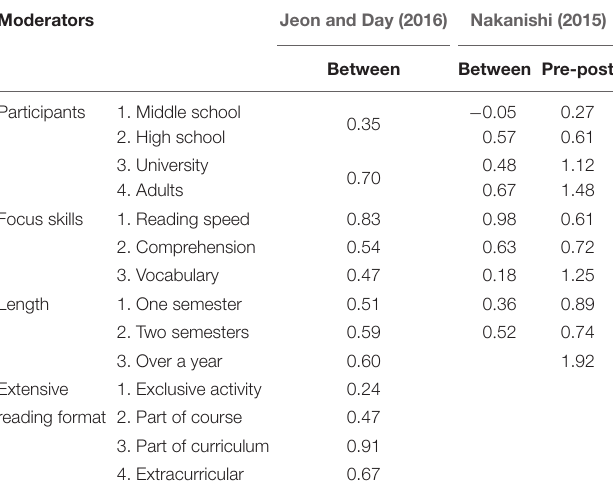
TABLE 2 | Different effects of extensive reading by moderator